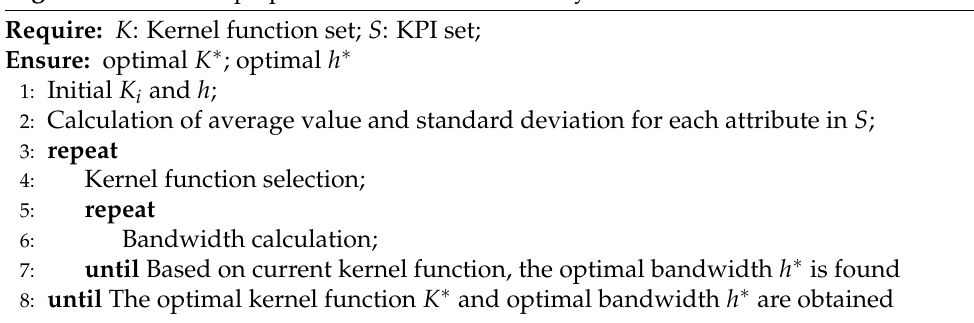
Algorithm 1 Two-step optimization in kernel density